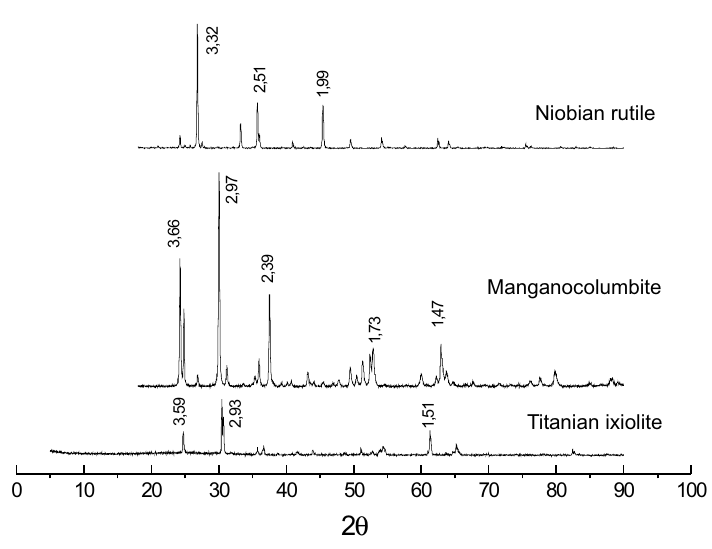
Fig. 5 – X-ray diffractograms of titanian ixiolite and niobian rutile from the Quintos pegmatite in comparison with those for manganocolumbite from the Boqueirão pegmatite in the Borborema Pegmatitic Province, Northeast